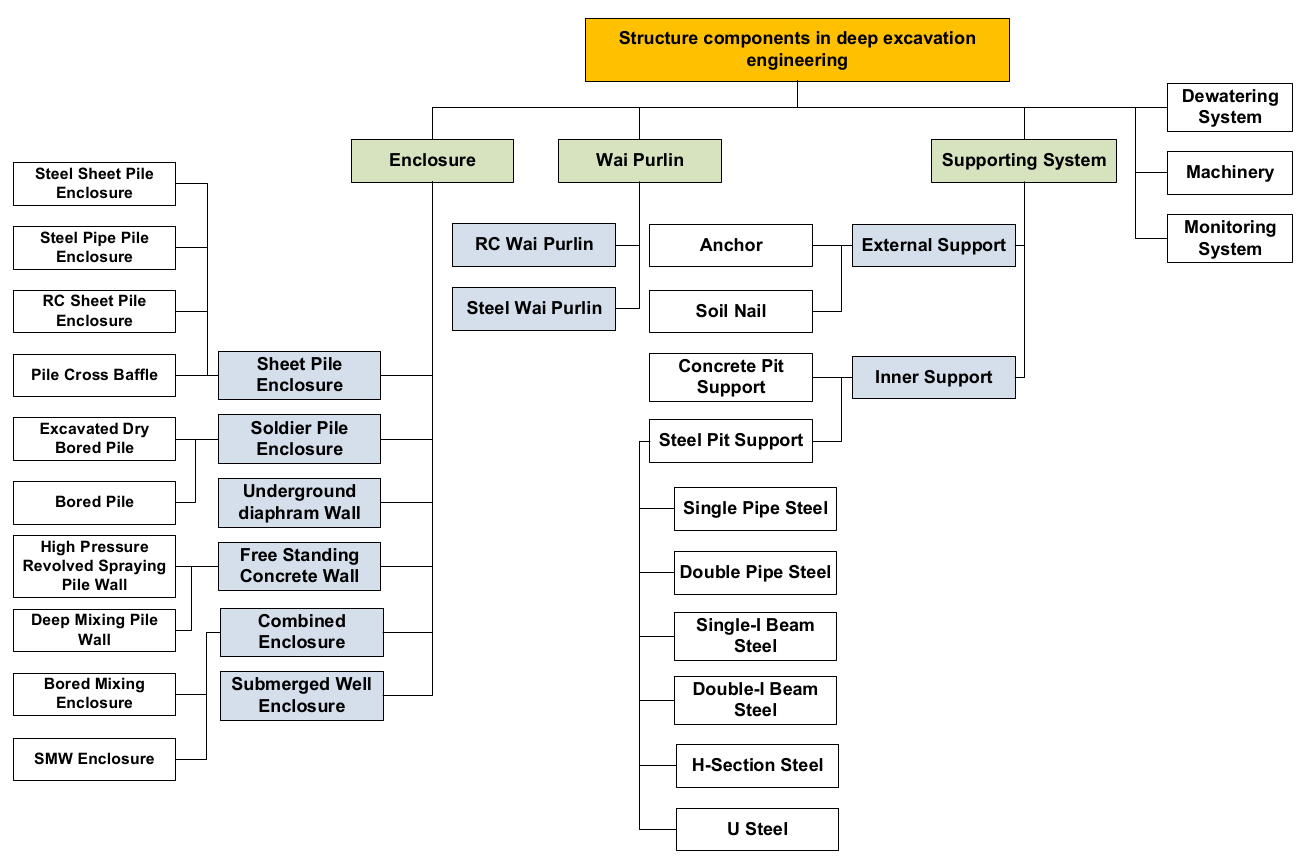
Figure 4. Main structure components in deep excavation.